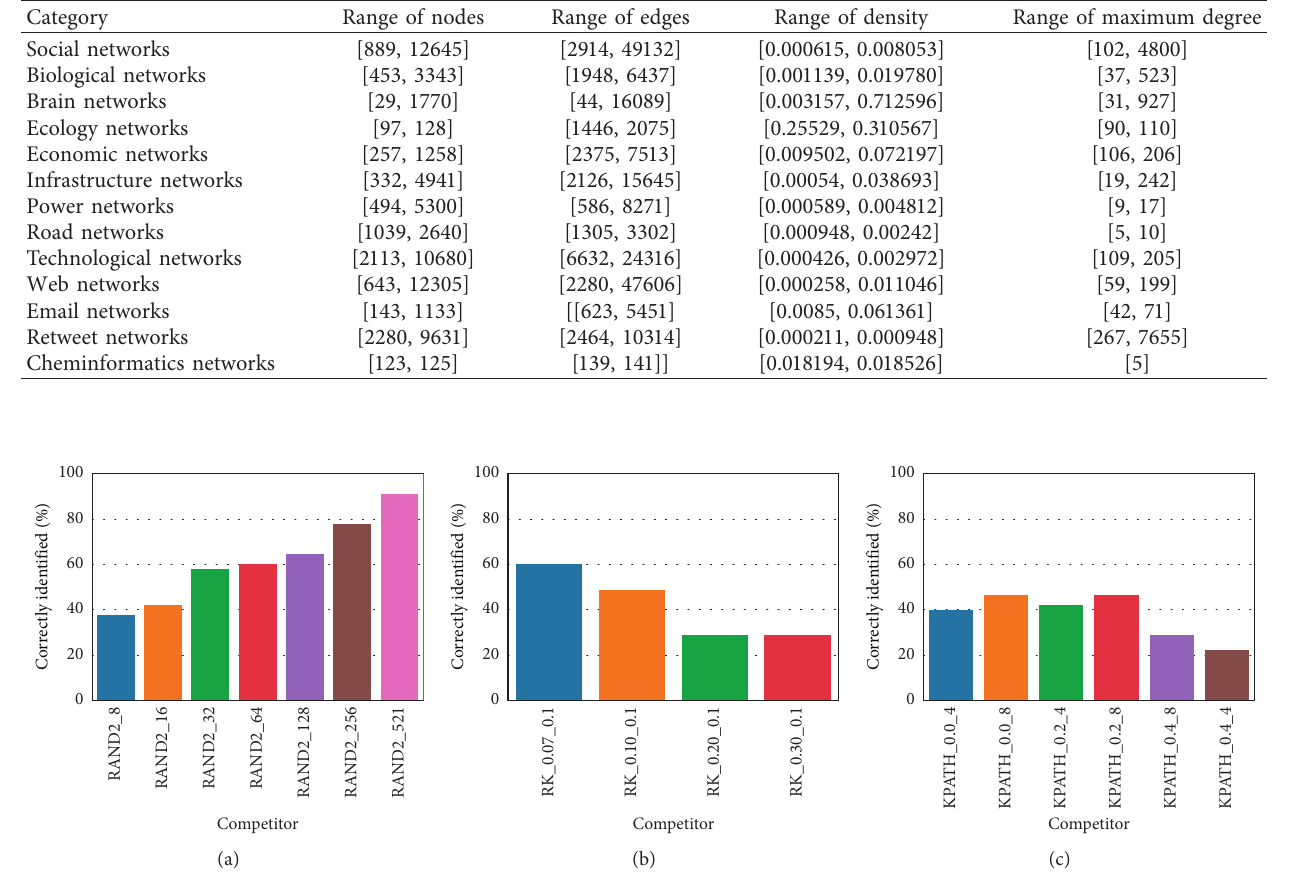
Table 3: Overview of the real-world datasets.